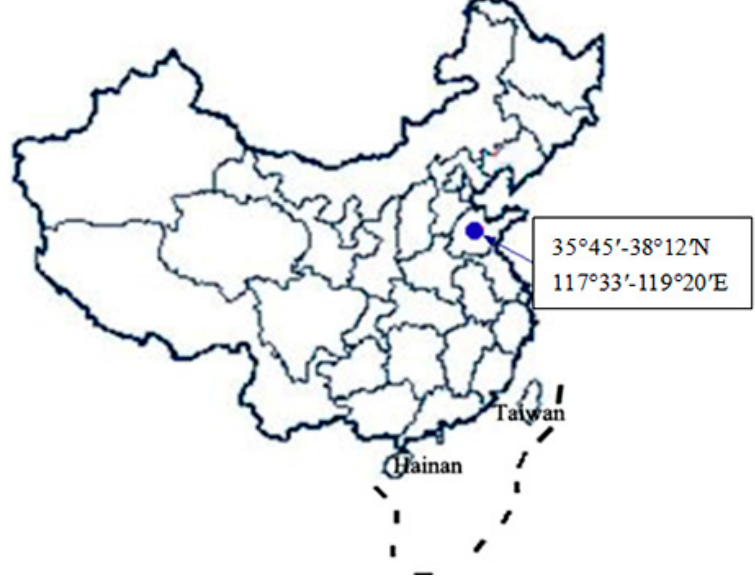
Figure 1. Map of the study area generated by Auto CAD2007 software. The dot on the map indicates the study area.